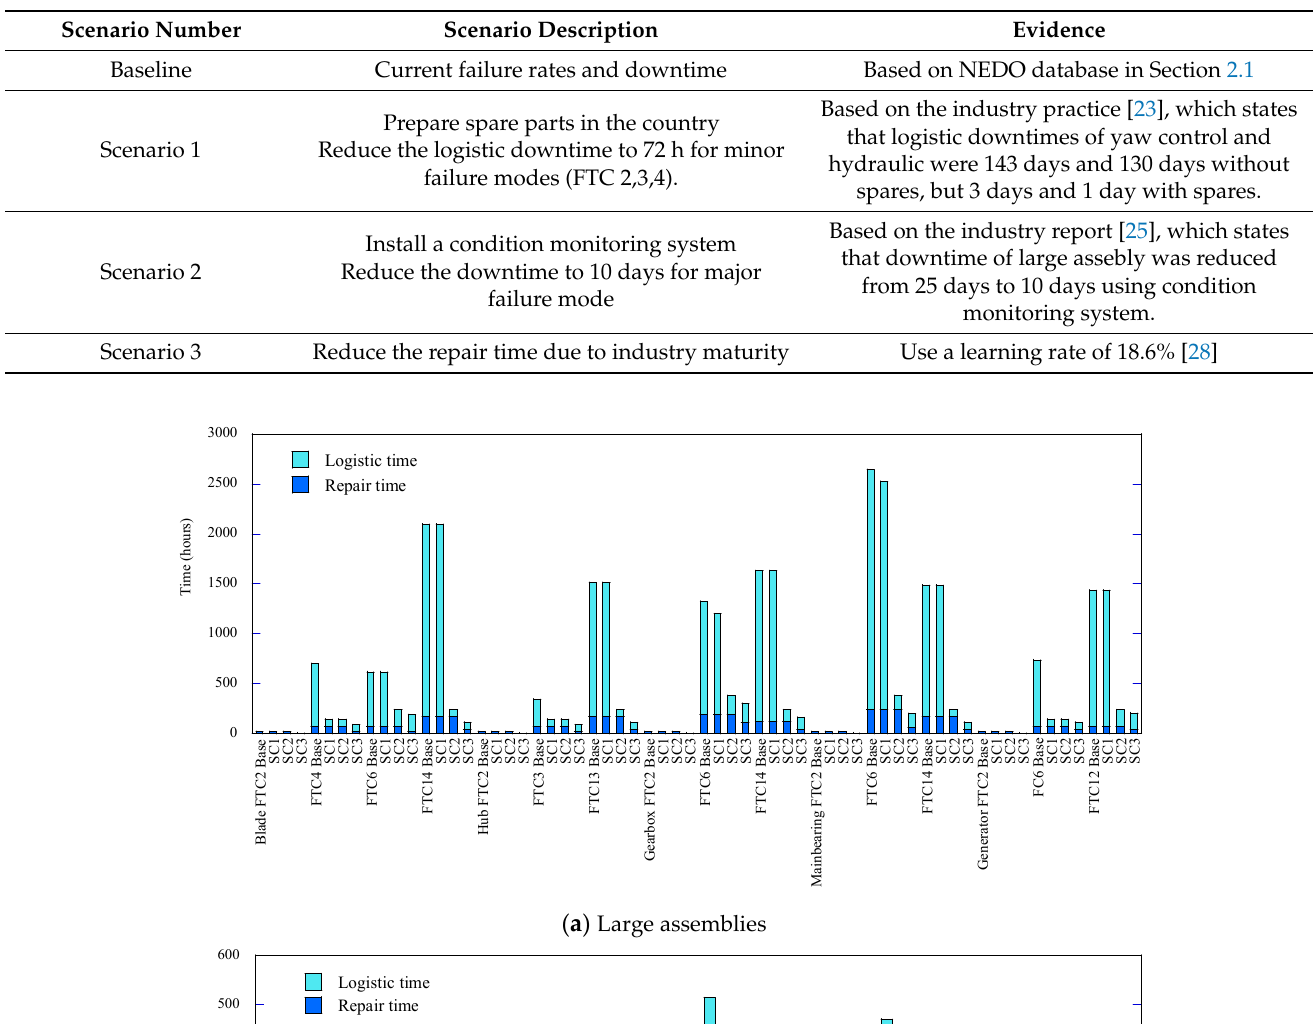
Table 6. Predicted availability for each scenario in Japan.